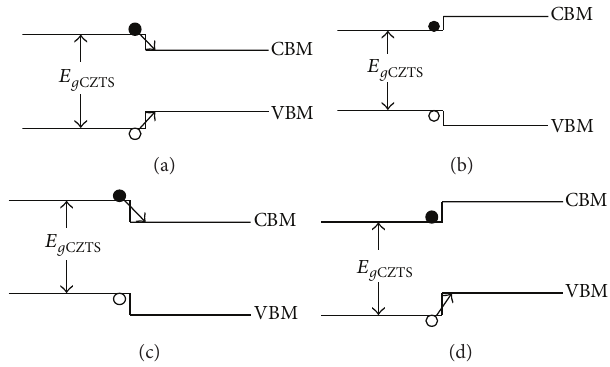
Figure 1: Band alignment of CZTS/secondary phase. (a) Type I heterointerface with 𝐸 𝑔 of the secondary phase smaller than that of CZTS. (b) Type I heterointerface with 𝐸 𝑔 of the secondary phase larger than that of CZTS. (c) Type II heterointerface with CBM and VBM in the secondary phase lower than that of CZTS. (d) Type II heterointerface with CBM and VBM in the secondary phase higher than that of CZTS.